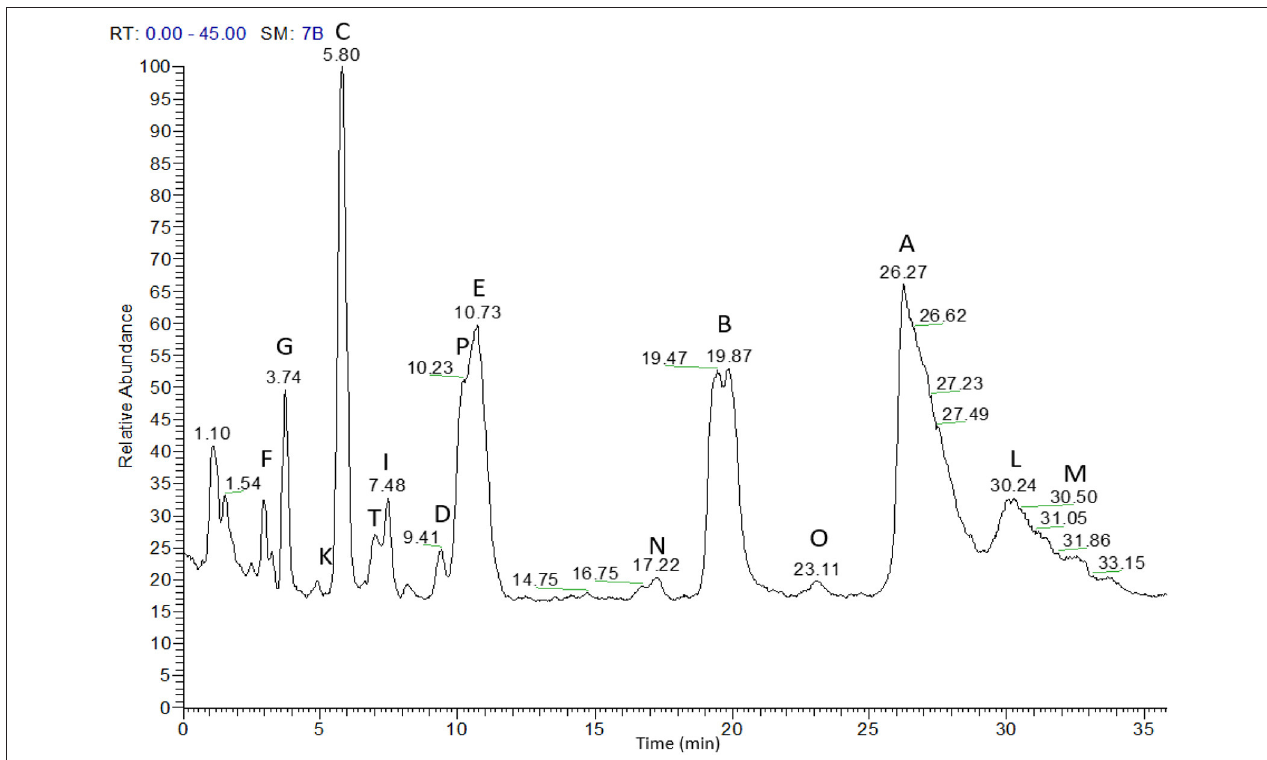
FIGURE 6 | RP-HPLC-Orbitrap MS analysis of flaxseed oil extract using a Kinetex TM C18